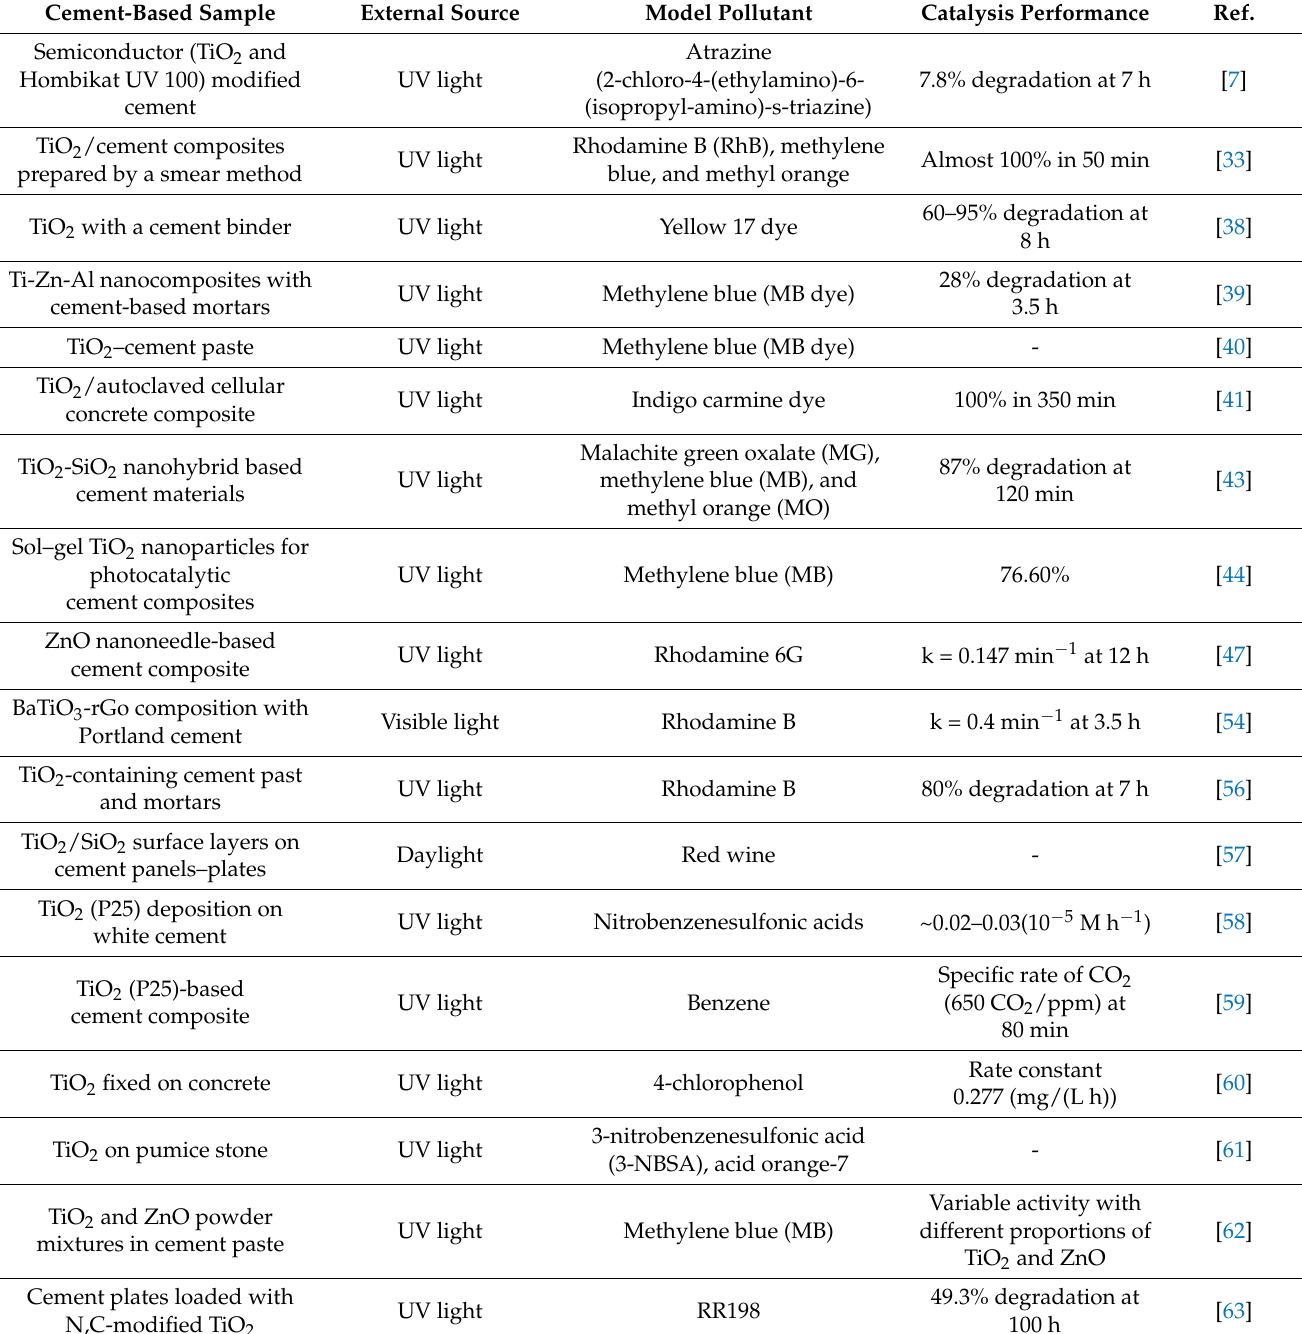
Table 1. Performance of various cement-based photocatalytic